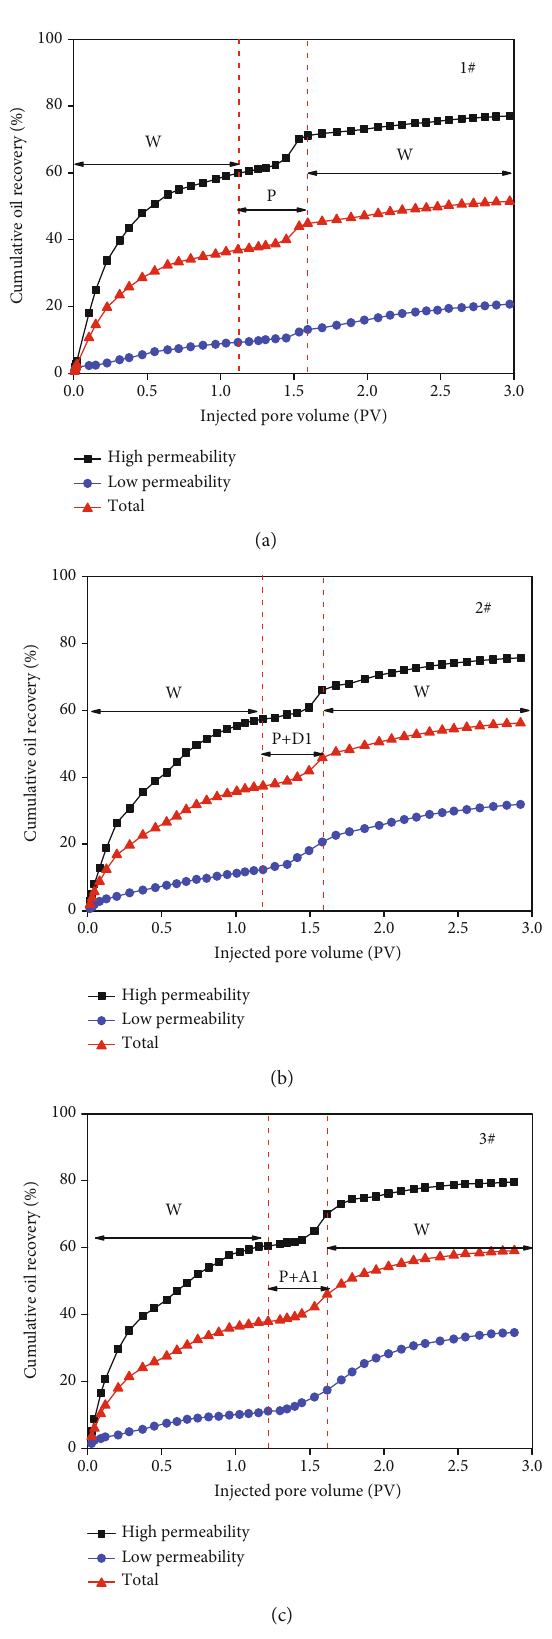
Figure 10: The cumulative oil recovery versus pore volumes injected: (a)1# — polymer fl ooding; (b)2# — polymer and D1 combination fl ooding; and (c)3# — polymer and A1 combination fl